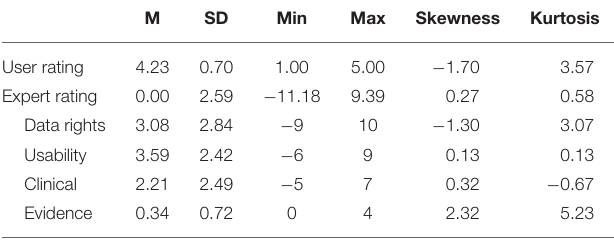
TABLE 1 | Descriptive statistics for user and expert ratings ( n =